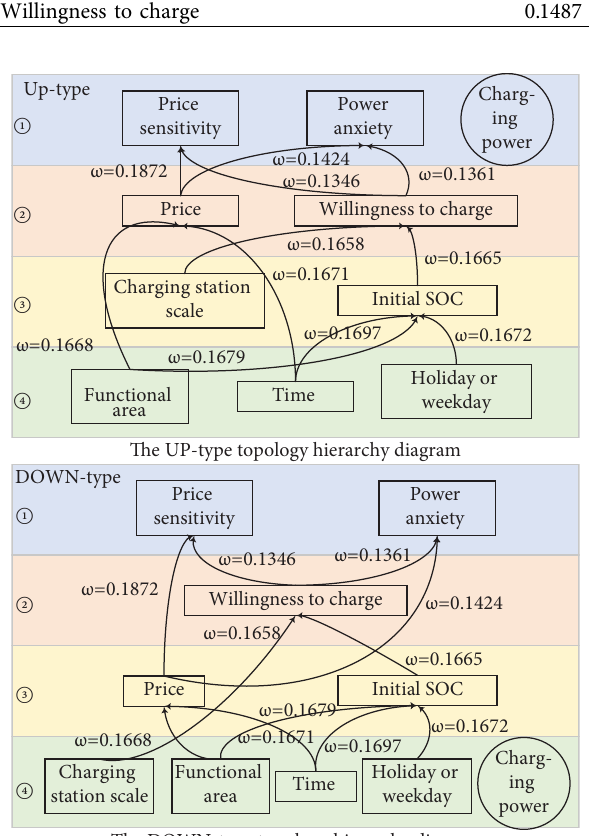
Figure 5: Te UP-type and DOWN-type topological hierarchy.